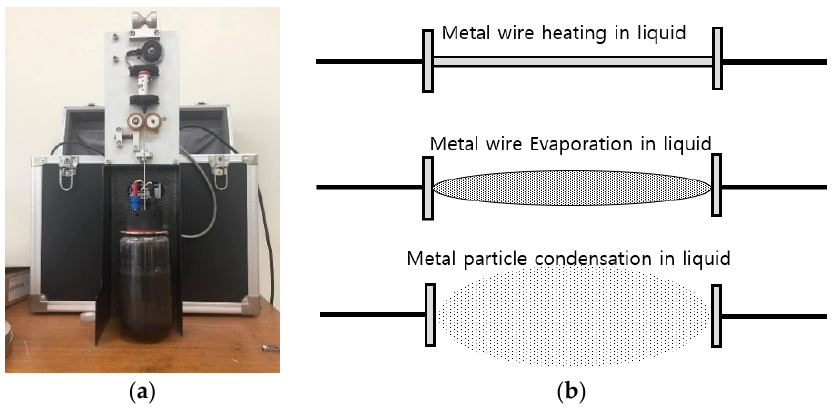
Figure 1. Principle of the pulse power wire evaporation (PWE) method. The charging voltage used to evaporate the metal wire should be adjusted according to the wire material. ( a ) Machine used to perform the pulse power wire evaporation (PWE) method; ( b ) principle of the PWE